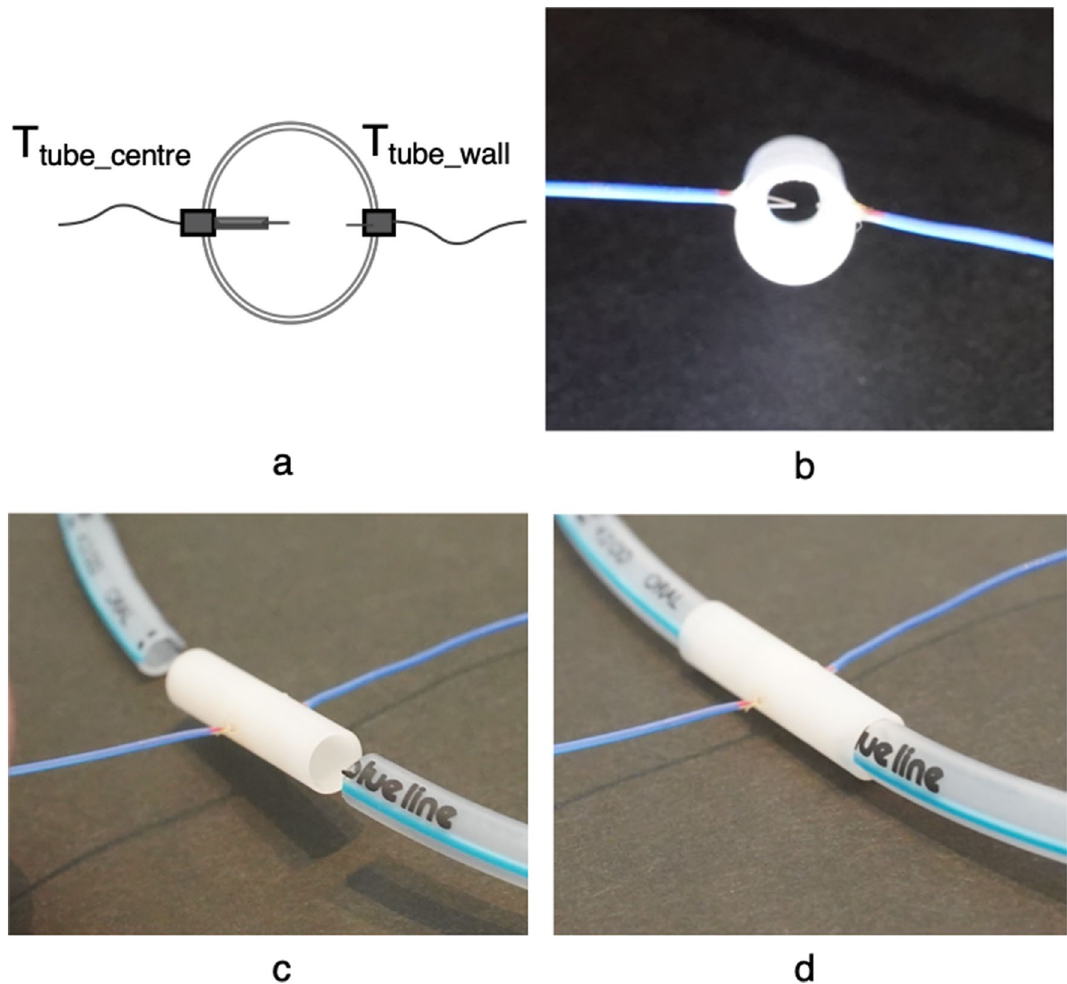
Figure 3. Diagram demonstrating the construction of an extension part of the endotracheal tube to monitor the respiratory gas temperature at the centre and the wall part of the tube. An extension part of the endotracheal tube was constructed by attaching two ultra-fast-response thermocouples [1.6 mm (T tube_centre ) and 0.5 mm (T tube_wall )] from the endotracheal tube wall toward the centre of the endotracheal tube ( a , b ). This extension part was inserted between the distal and proximal parts of the endotracheal tube at the level of the mouth ( c , d ). T tube_centre temperature at the centre of the endotracheal tube; and T tube_wall temperature at the wall surface of the endotracheal incubator and a peripheral venous catheter was inserted to give maintenance fluid (10% glucose, 80 ml/kg/day) and anaesthetics. The room was air-conditioned to maintain the ambient temperature of 26 °C. The electrocar- diogram and percutaneous arterial oxygen saturation were monitored continuously, whereas non-invasive blood pressure and blood gases were assessed approximately every 30 min. General anaesthesia was then induced by 5% sevoflurane using a mask, and the piglet was intubated using a cuffed endotracheal tube with the internal diameter of 3 mm. The piglet was then placed in the left-lateral position and mechanically ventilated to main- tain normal PCO 2 using the pressure-control ventilation mode. Anaesthesia was maintained by 2–5% inhaled sevoflurane, a continuous intravenous infusion of dexmedetomidine (1 μg/kg/h) and intravenous pancuronium injections (0.7 mg/kg/dose, approximately every 30 min). The body temperature of the piglet was maintained at 38.5 ± 0.5 °C using a radiant heater, which was servo-controlled with rectal temperature feedback. Temperature monitoring. A custom-made airway thermometer was developed using an ultra-fast- response thermocouple (time constant, 0.05 ms; FasTemp, Aivision, Tokyo, Japan) at the distal tip of the closed suction system (Ecocath, Medtronic plc., Dublin, Ireland). The respiratory gas temperature at the Y-piece of the ventilator circuit was monitored using a built-in thermometer of the humidifying system (MR 730, Fisher and Paykel, Auckland, New Zealand) and another FasTemp probe (T Y-piece ). To assess the accuracy of the temperature measured using the airway thermometer (T airway ), another custom-made system was developed by attaching two FasTemp probes to an 8 mm long tube with an internal diameter of 3.2 mm, 1.6 mm (T tube_centre ) and 0.5 mm (T tube_wall ) from the endotracheal tube wall to the centre of the endotracheal tube (Fig. 3); this unit was inserted